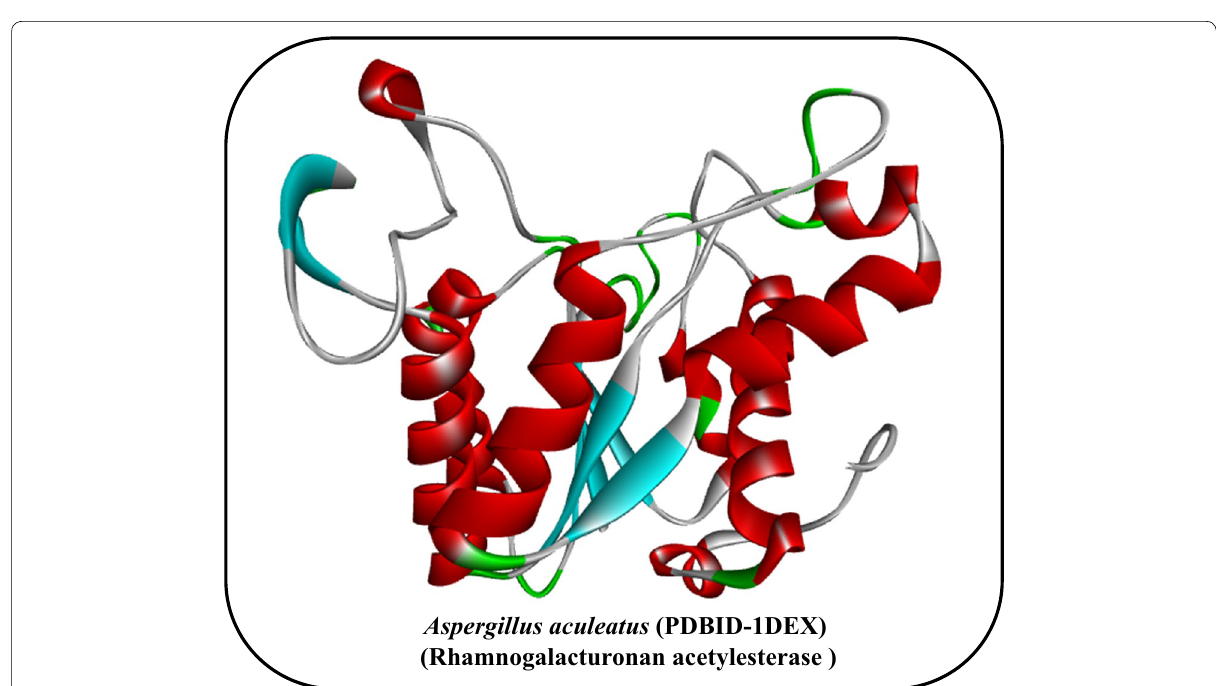
Fig. 3 The protein secondary structure of Aspergillus aculeatus rhamnogalacturonan acetylesterase (carbohydrate esterase class-12) (PDB ID:1DEX) (Mølgaard et al. 2000), where alpha-helices (red), beta strands (blue) and coils (gray). (Image was developed using Discovery Studio Visualizer ®